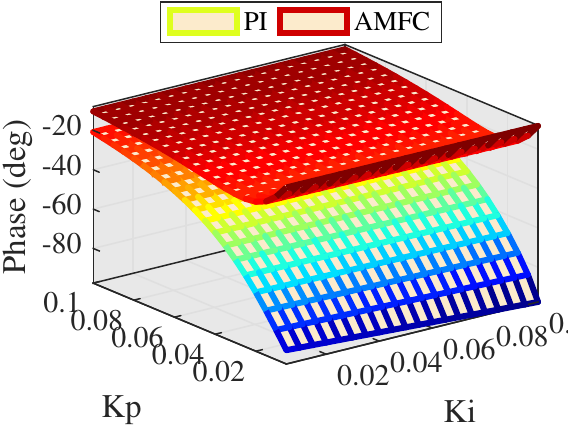
Figure 10. Phase comparison between PI and AMFC α = 0.5. As can be seen Figure 9, the amplitude response of AMFC performs a little better than PI control at low PI parameters, and Figure 10 shows that AMFC performs much better phase response than PI control and the phase lag is reduced from 20 to 10 degrees. This indicates AMFC improves phase response and it is necessary to enhance value of α . If the value of α increases up to 1, comparisons of amplitude and phase between PI control and AMFC are depicted in Figures 11 and 12, respectively.